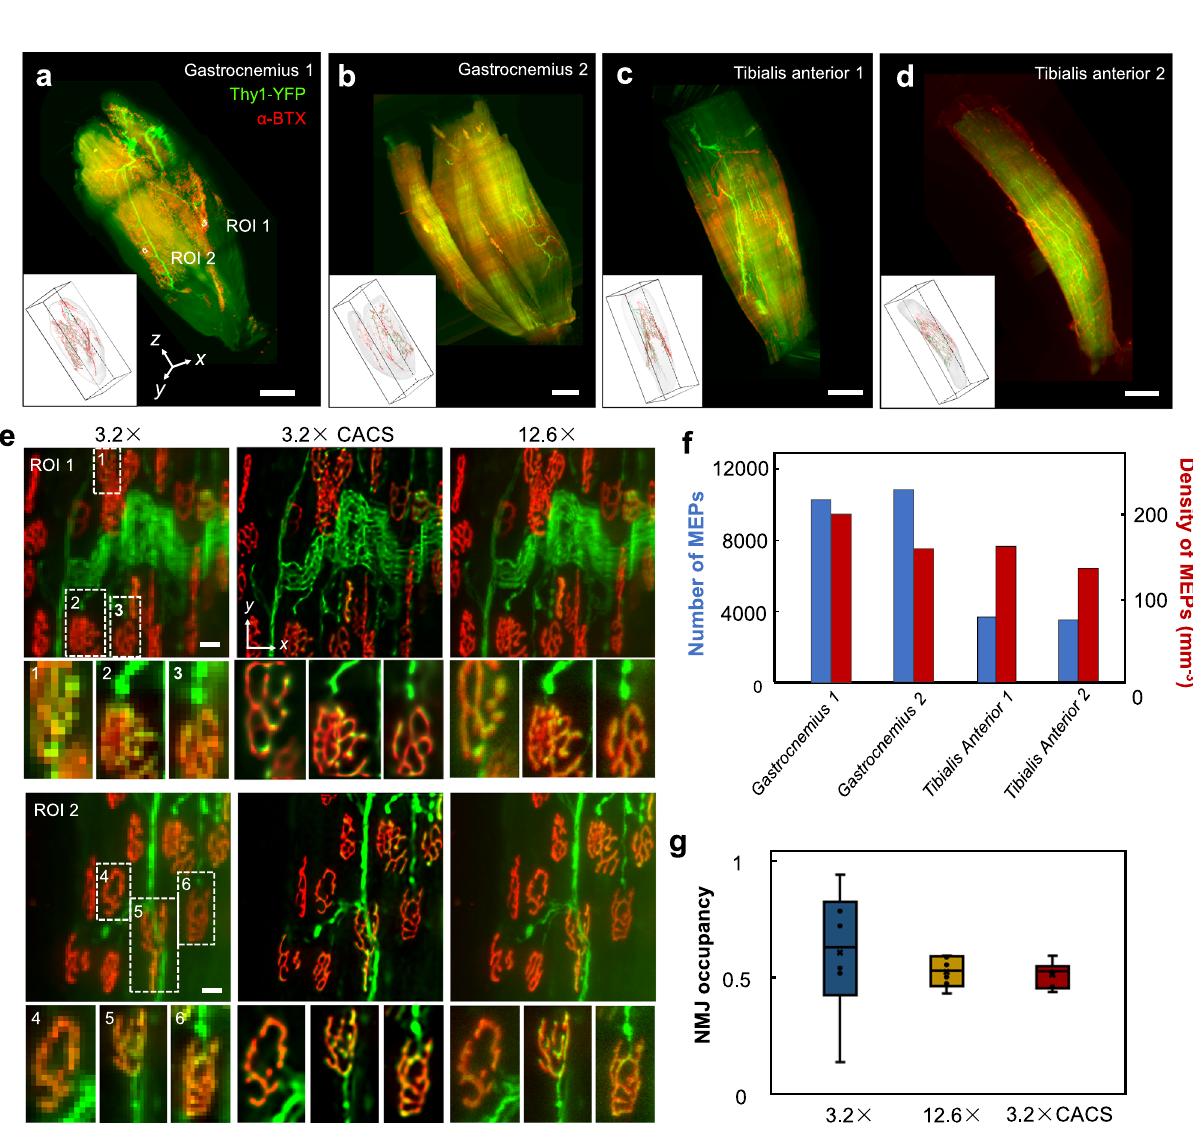
Fig. 5 Dual-color CACS imaging and quantitative analyses of neuromuscular junctions in mouse Gastrocnemius and Tibialis anterior. a – d Dual-color, 3D visualization of Gastrocnemius and Tibialis anteriors, showing both the presynaptic terminal bouton (green, Thy1-YFP) and postsynaptic acetylcholine receptors (red, α -BTX). Insets show image-based segmentation of presynaptic terminal and MEPs. e , Comparison of two ROIs (100 × 100 × 100 μ m 3 ) in a, by ×3.2 (left column), ×3.2 CACS (middle column), and ×12.6 Bessel sheet (right column). Six magni fi ed views (white boxes, 1, 2, 3 for ROI1 and 4, 5, 6 for ROI2) further demonstrate the structural information of single NMJs. Scale bar, 10 μ m. f Macroscale quantitative analysis of MEP, including total numbers and densities of MEPs, in two types of muscles ( n = 4 biologically independent samples). g Neuromuscular junction (NMJ) occupancy calculated based on abovementioned ×3.2, ×3.2 CACS, and ×12.6 Bessel sheet images that show different level of resolution. (maxima/minima: the maximum/minimum values; centre: the medium value; bounds: upper and lower quartile) The result from raw ×3.2 image shows an unacceptably large error range, owing to the ambiguous cellular resolution. Here NMJ occupancy was calculated as (presynaptic volume/postsynaptic volume) ×100%. Data are presented as mean values ± SD ( n = 6 biologically independent samples). Source Data are available as a Source Data File.